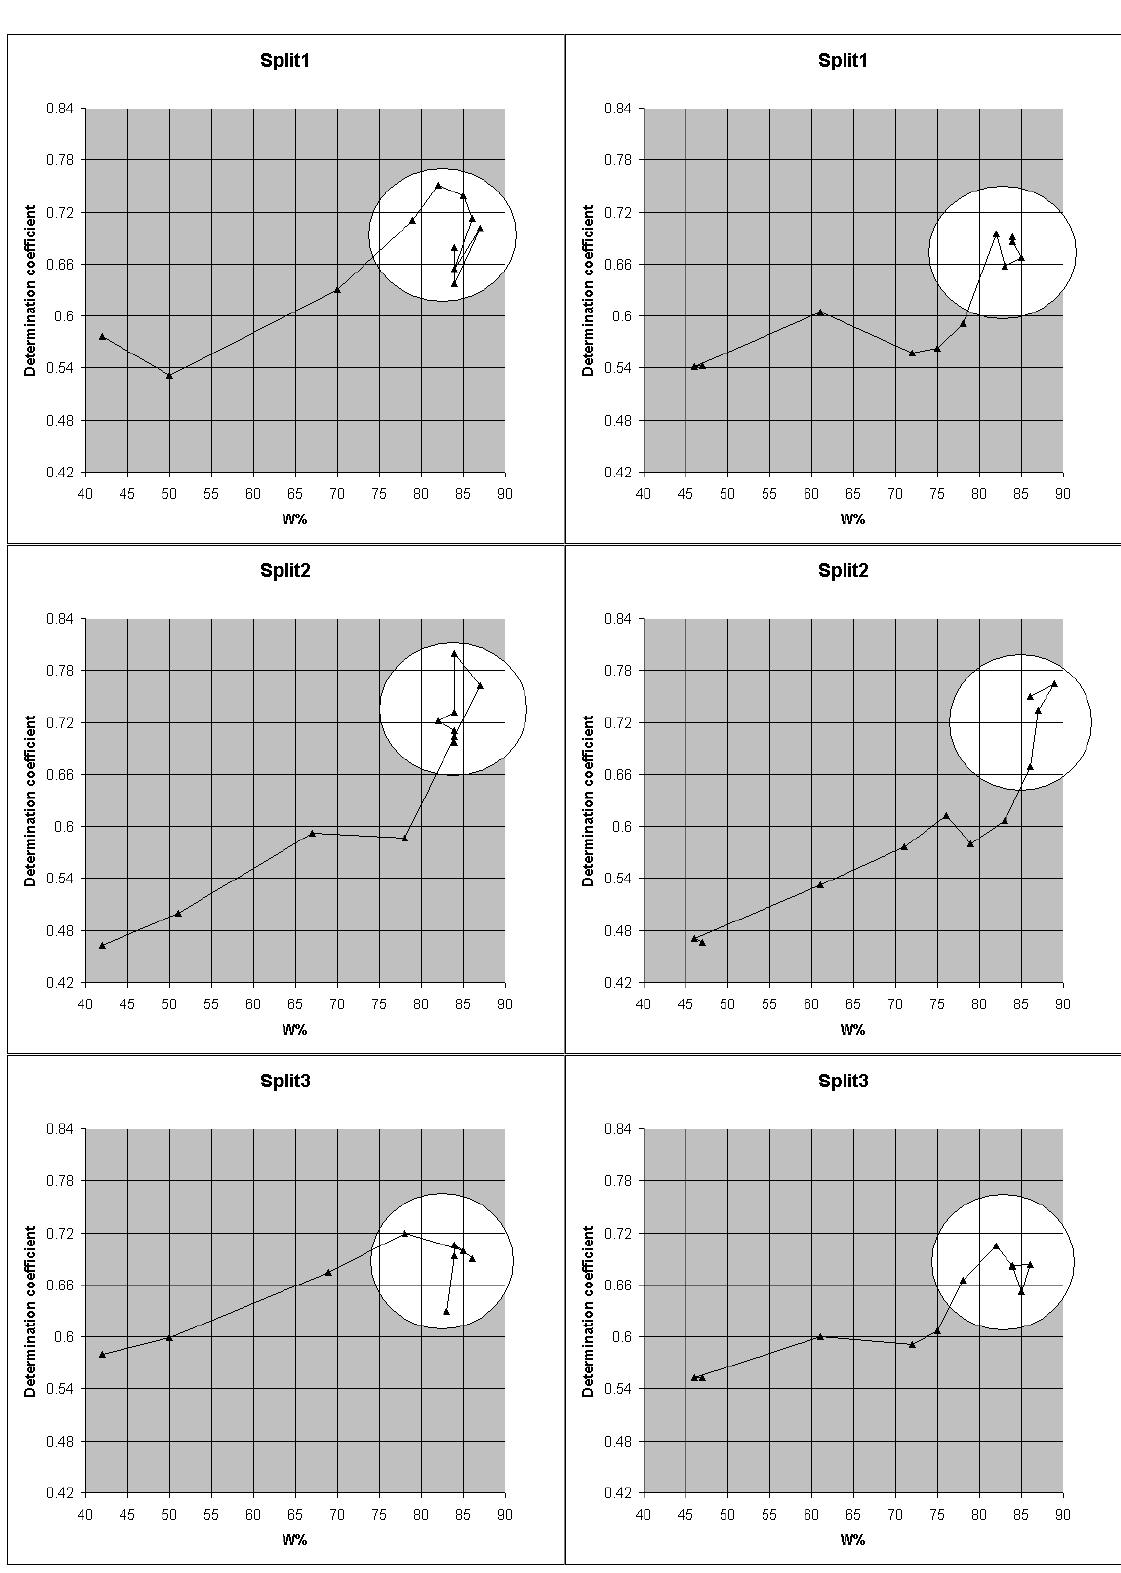
Figure 4. Correlations between the determination coefficient for test set and W% for the three splits (see data from Table